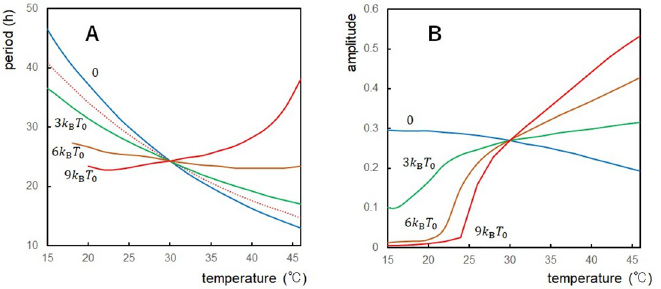
Fig 5. Temperature dependence of the period and amplitude simulated with a different activation energy of structural fluctuations. Period and amplitude of the ensemble-averaged phosphorylation level � D ð t Þ were calculated with various values of the activation energy of structural fluctuations Δ E f with Δ E f = 0 (blue), 3 k B T 0 (green), 6 k B T 0 (brown), and 9 k B T 0 (red) with T 0 = 30˚C. ( A ) Period plotted for each Δ E f as a function of temperature. Compared is the relative change of 1/rate of the process having the 10 k B T 0 activation energy (red dotted line). ( B ) Amplitude plotted for each Δ E f as a function of temperature. N =